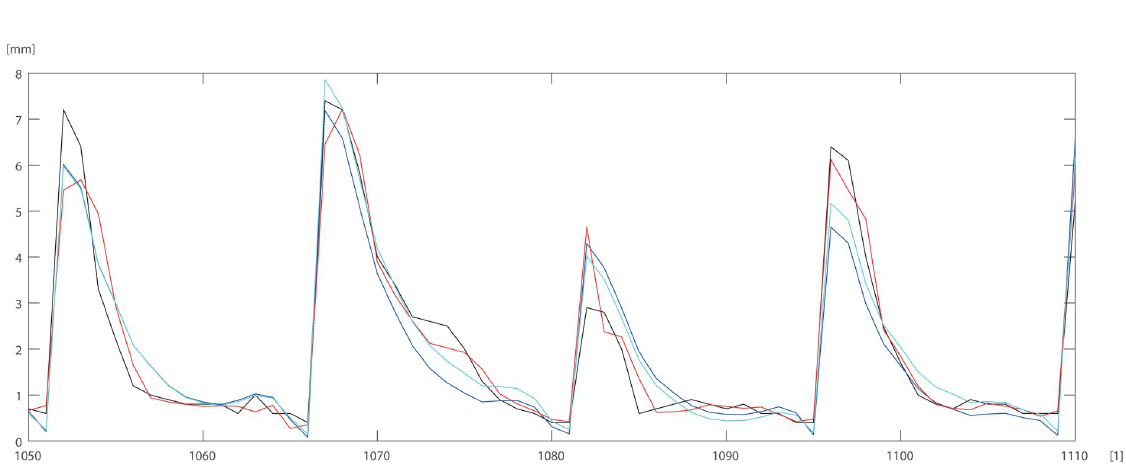
Fig 10. 400 DBT data (black line), STAT 2 (blue line), STAT 1 (cyan line), ANN (red line) for oak. Horizontal axis [1]—identifier of measurement.